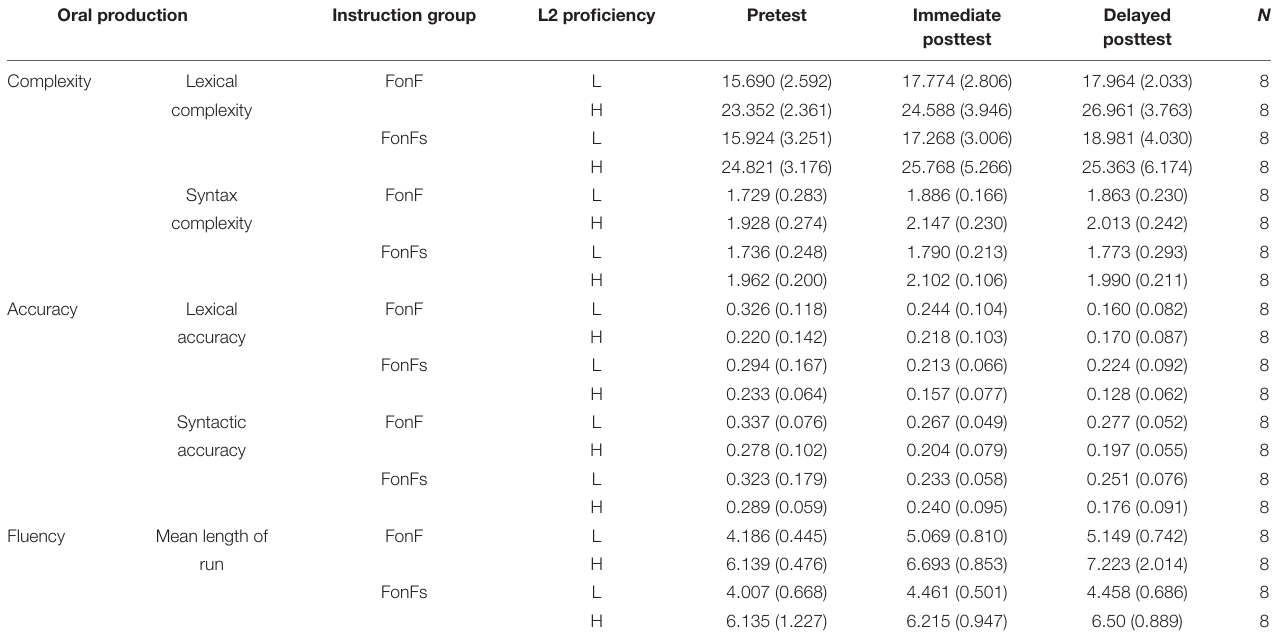
TABLE 4 | Descriptive statistical results for oral